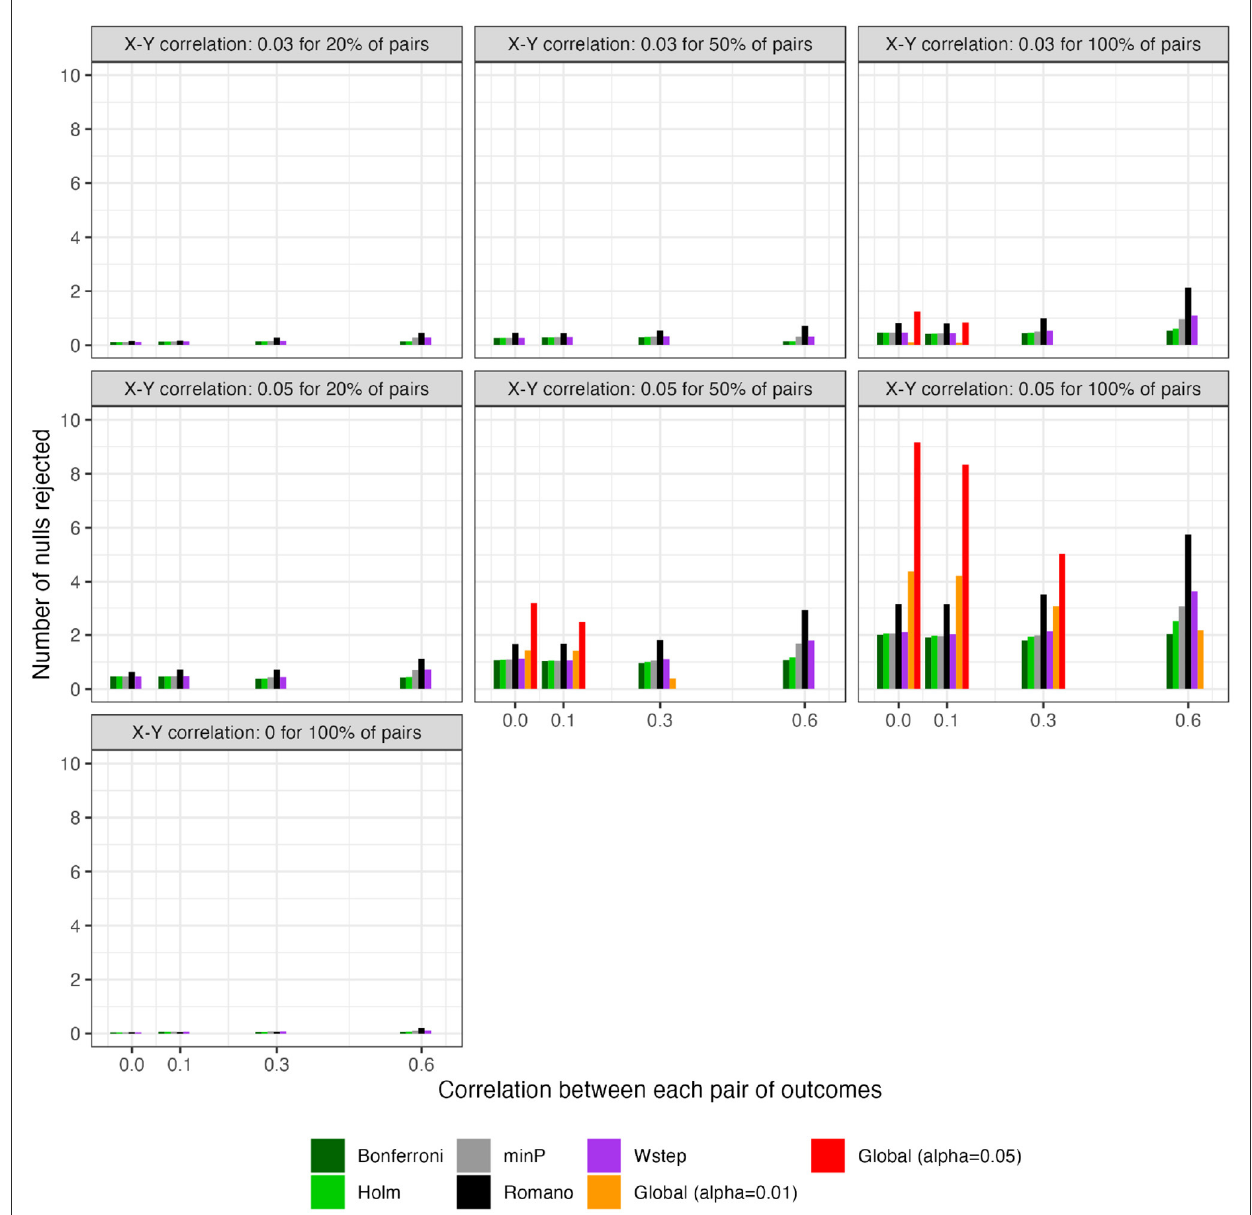
FIGURE4 For scenarios with 40 outcomes, number of rejected null hypotheses at familywise-controlled α W = 0.05 based on existing FWER-control procedures and on the excess hits. “Global (alpha = 0.01)” and “Global (alpha = 0.05)”: proposed methods. Red dashed line: Actual number of false null hypotheses ( q × W